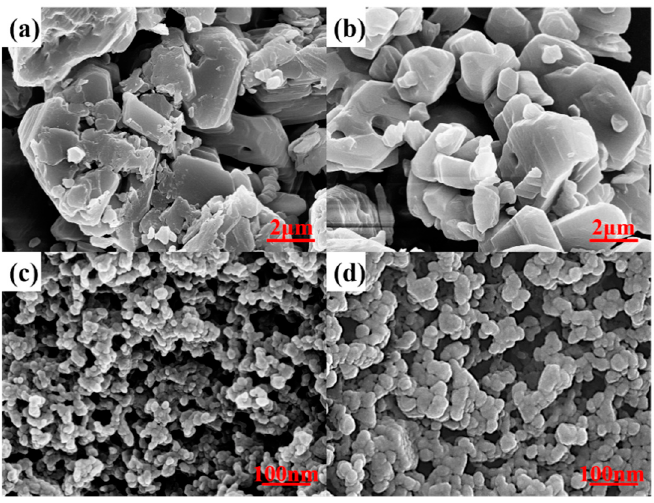
Figure 5. The SEM pictures of four TATB samples ( a ) μ TATB-1, ( b ) μ TATB-2, ( c ) nTATB-1, ( d ) nTATB-2.